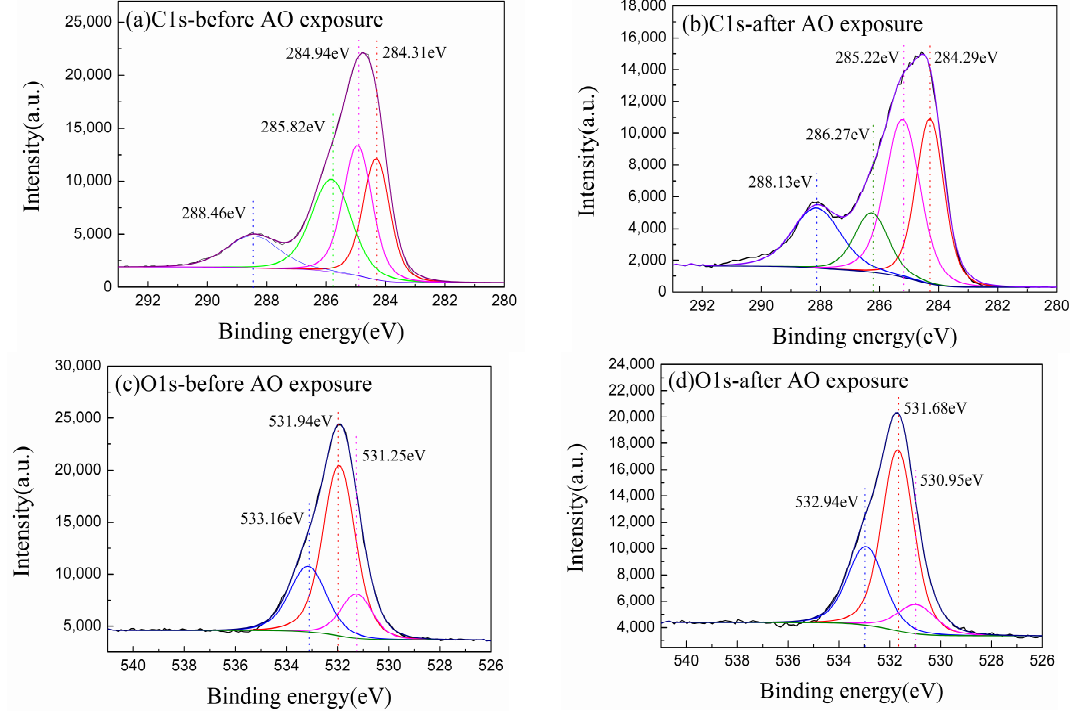
Figure 16. High-resolution spectra of C1 s and O1 s before and after exposure to Kapton/Al 2 O 3 films: ( a , b ): C1 s ; ( c , d ): O1 s ( a , b ): C1 s ; ( c , d ): O1 s .